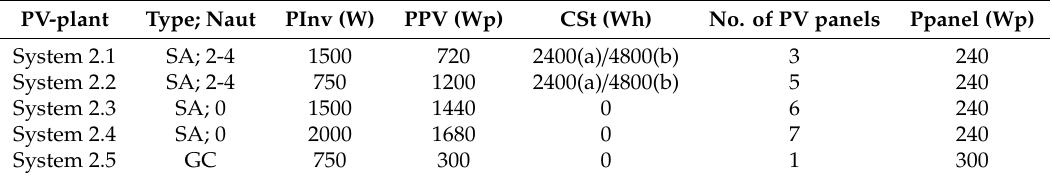
Table 4. PV plant Table 4. PV plant features.